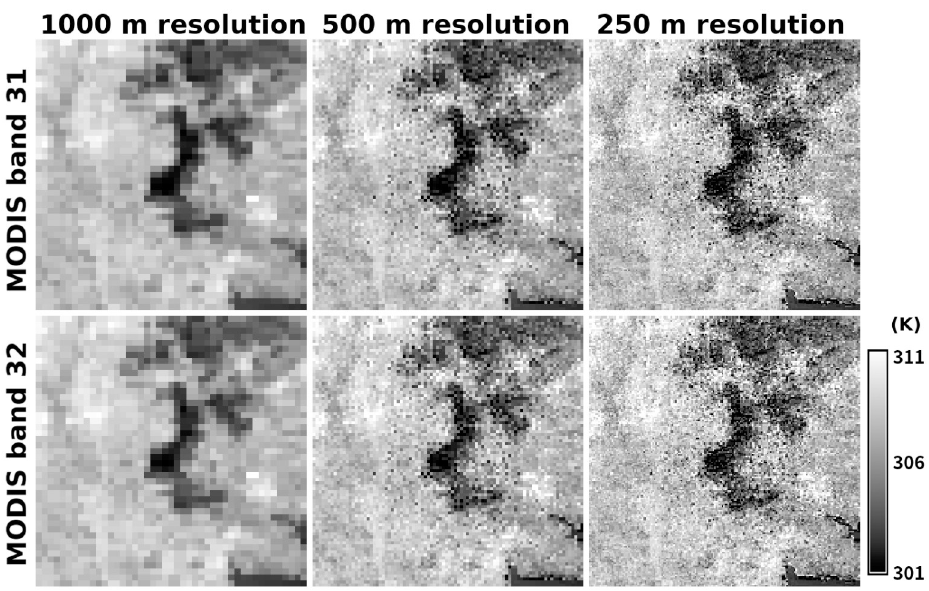
Fig 7. Improvement in spatial resolution of MODIS thermal infrared bands by the proposed super-resolution Algorithm 3. (left column) Original 1000-m resolution images, (center column) result from the first super-resolution process, and (right column) result from the second super-resolution process for (top row) MODIS band 31 and (bottom row) MODIS band 32. The radiance value was converted into brightness temperature by Eq 10.